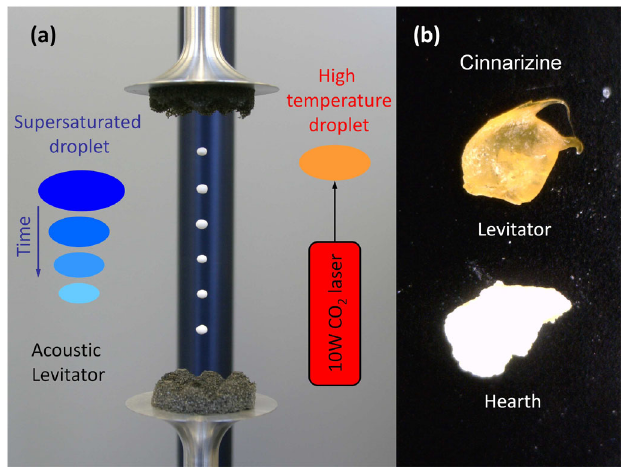
FIG. 1. (a) Photograph of the acoustic levitator levitating sev- eral samples simultaneously (shown as white spheres) with a 14 mm spacing. The illustrations on either side of the levitator show the two methods of forming amorphous forms of pharma- ceutical drugs in this study. (b) A photograph of pure Cinnarizine melted in the levitator to form a yellow amorphous product, compared to the same starting material melted in the laser hearth that formed a white crystalline product.